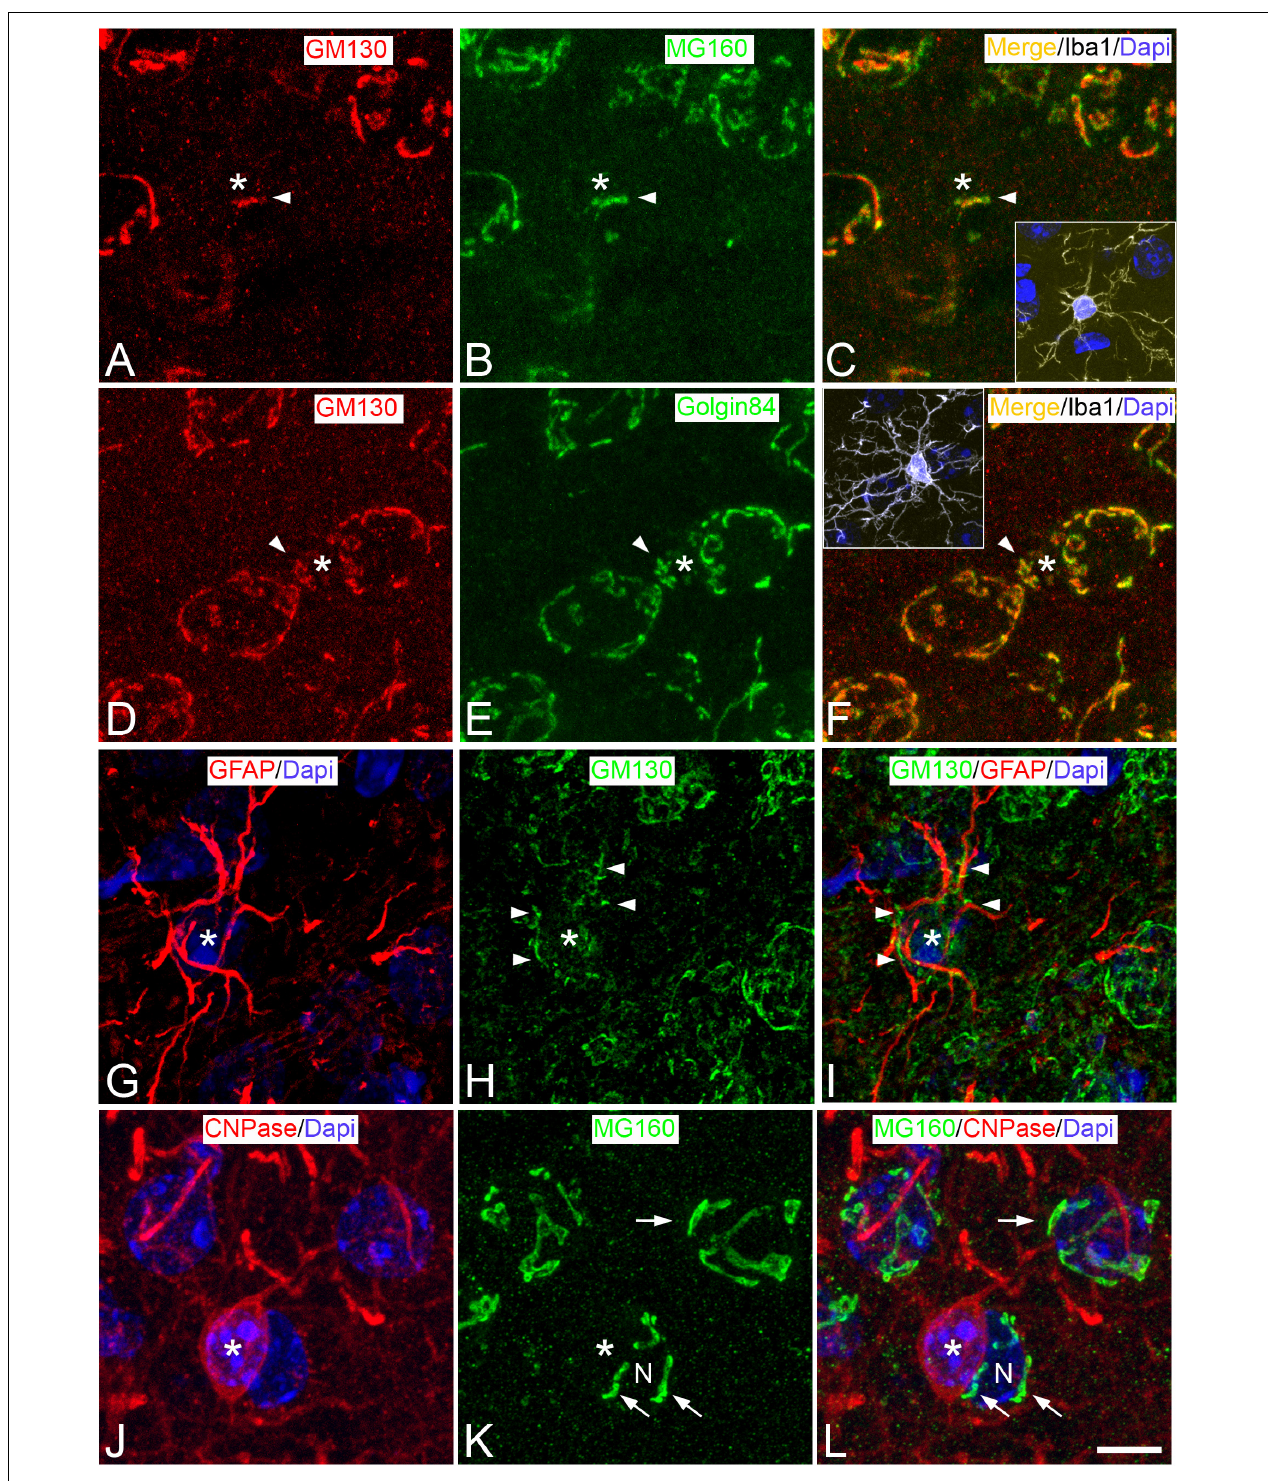
FIGURE 1 | Distribution of GA proteins in neocortical glial cells from euthermic hamsters. (A–L) Trios of images taken from neocortical sections immunostained simultaneously for MG160/GM130/Iba-1 (A–C) , GM130/Golgin84/Iba-1 (D–F) ; GFAP/GM130 (G–I) , and CNPase/MG160 (J–L) showing the distribution of GA proteins in the GA (arrow heads) of microglial (A–F) , astrocytes (G–I) , and oligodendrocytes (J–L) from euthermic hamsters. In microglial cells, note the similar distribution patterns of GM130, MG160, and Golgin84 and the high degree of colocalization. Insets in panels (C) and (F) show the cell bodies of microglial cells identified by Iba-1 immunostaining (white). Asterisks in panels (G–I) and (J–L) indicate respectively the cell body of one astrocyte and one oligodendrocyte adjacent to a neuron (N). The arrow indicates the GA of the neuron N. Scale bar shown in panel (L) represents 7.2 µ m in all panels, and 15.8 µ m in the insets.